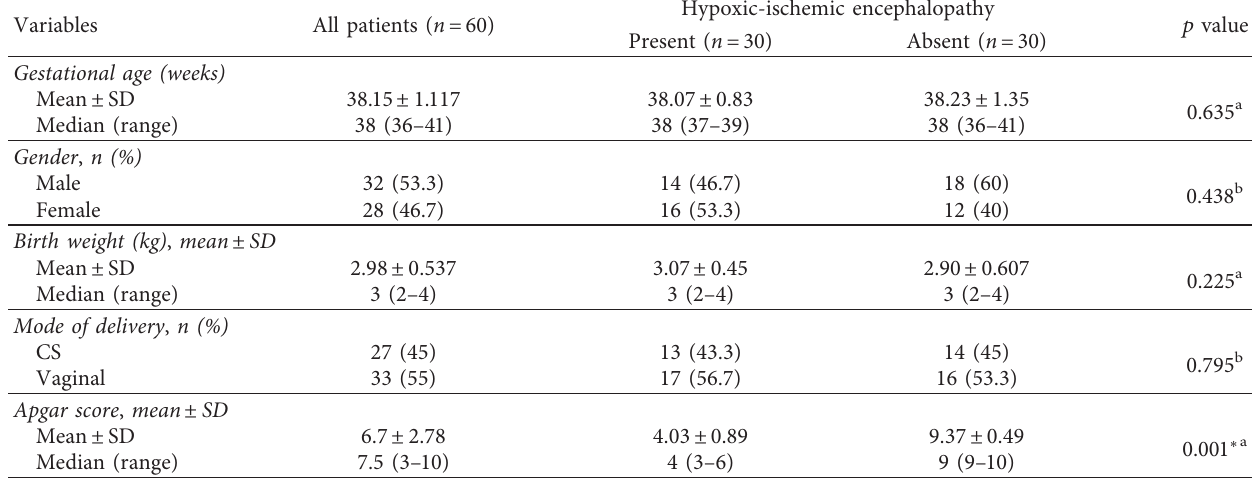
Table 1: Baseline characteristics of the studied sample.